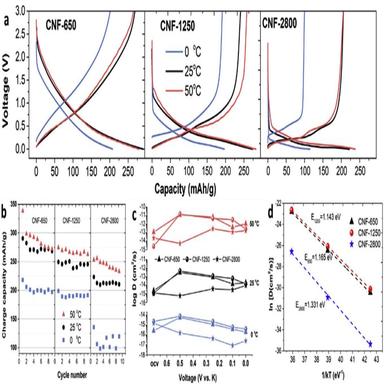
Temperature-dependence behavior. (a) Voltage profile, (b) cyclic performance and (c) diffusivity of K-ion of CNFs under different temperatures. (d) Arrhenius plot of the diffusivity as a function of 1/kT for CNFs. (A colour version of this figure can be viewed online.)